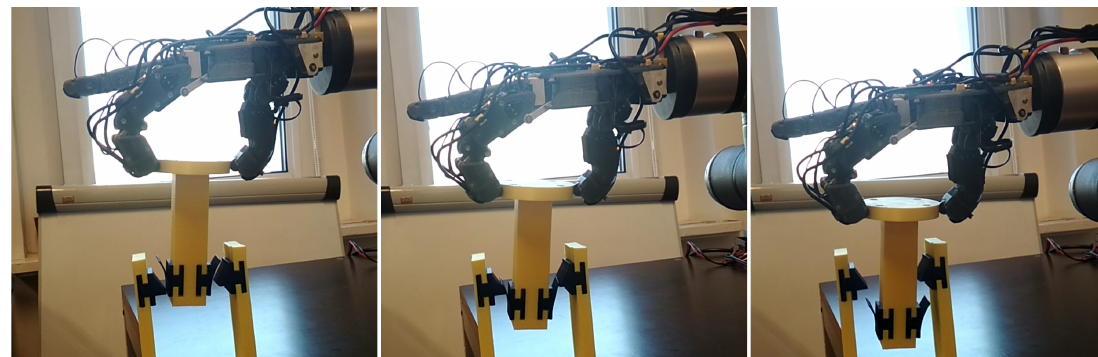
Figure 22. UR3 robot equipped with PUT-Hand inserting the plug into the socket.